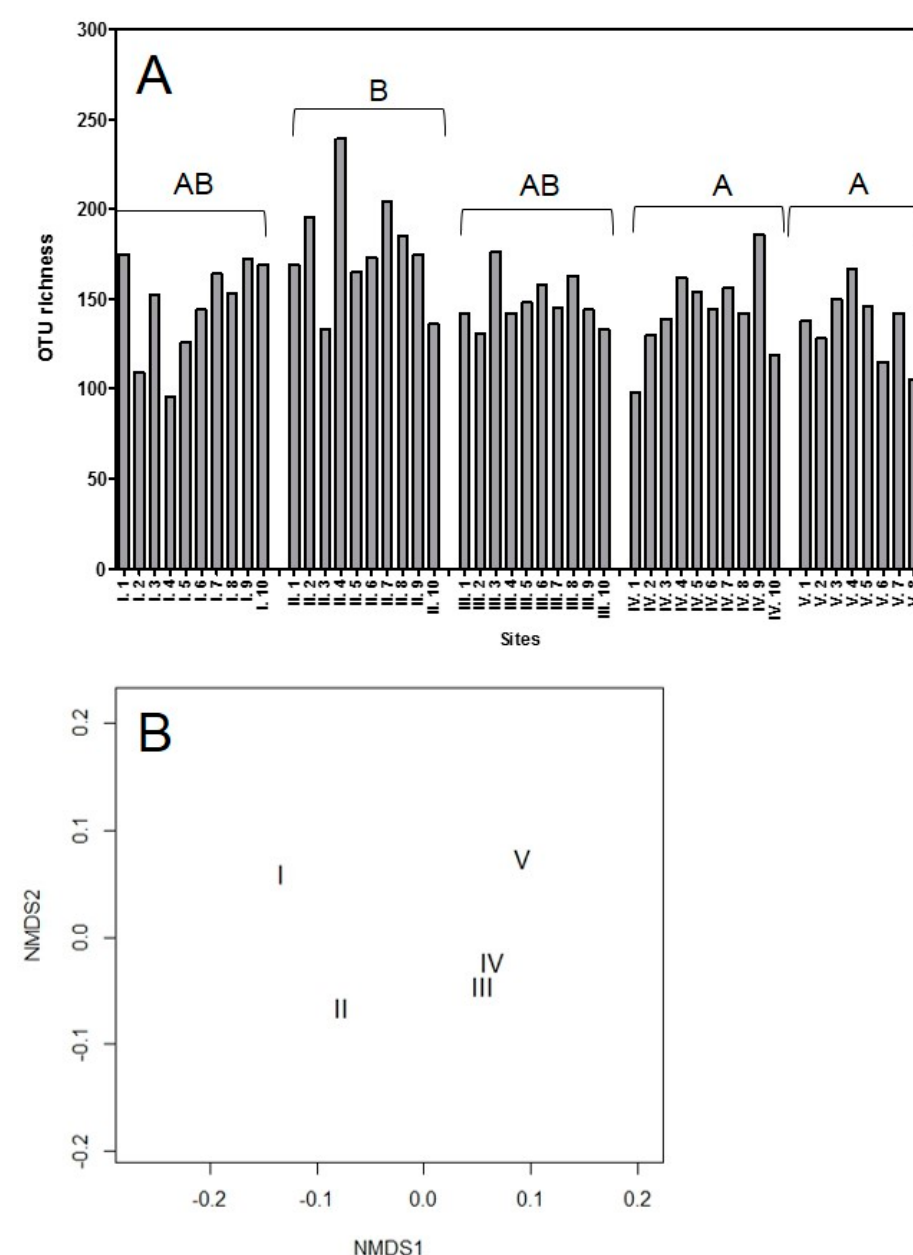
Figure 1. OTU richness determined by direct amplicon sequencing of roots from five sites and community composition. ( A ) Variation in OTU richness across five sites at individual plant level. Capital letters show differences in mean number of OTUs identified per site. Different capital letters represent significant differences; sites sharing the same letter are not significantly different ( p ≤ 0.05). Created in GraphPad Prism 5. ( B ) Comparison of the community composition between the five sites using non-metric multidimensional scaling, stress was <0.05. Created in R version 3.4.3.